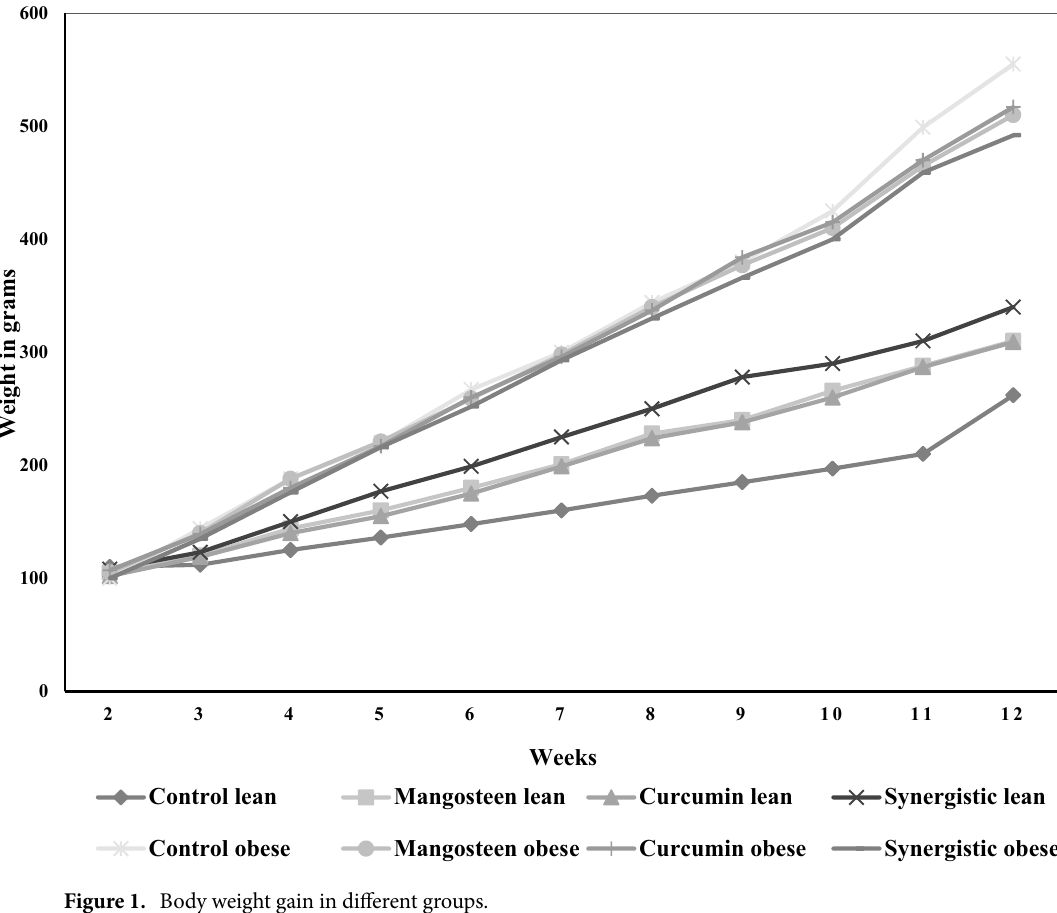
Figure 1. Body weight gain in different